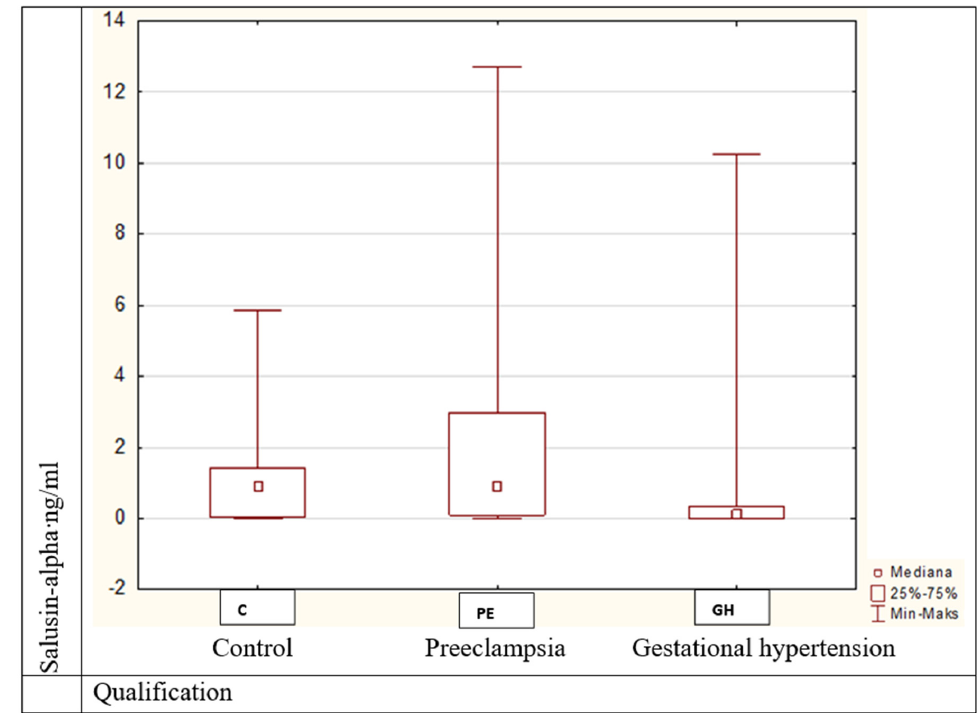
Figure 3 Figure 3. Salusin-alpha values in pregnant women between the examined groups, p = 0.003. (3). Apelin’s values differed statistically significantly (Kruskal–Wallis H = 9.85, p = 0.007).